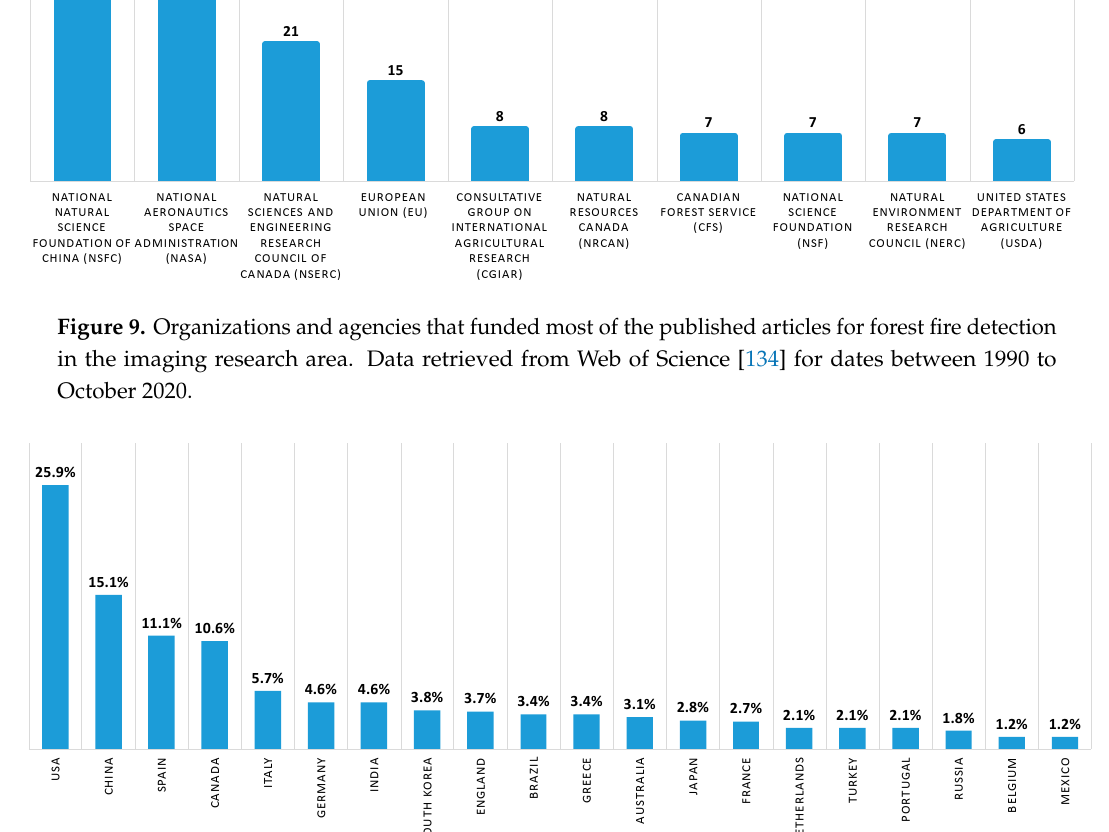
Figure 10. Authors’ affiliation by country (%) for forest fire detection in the imaging research area. Data retrieved from Web of Science [134] for dates between 1990 to October 2020.